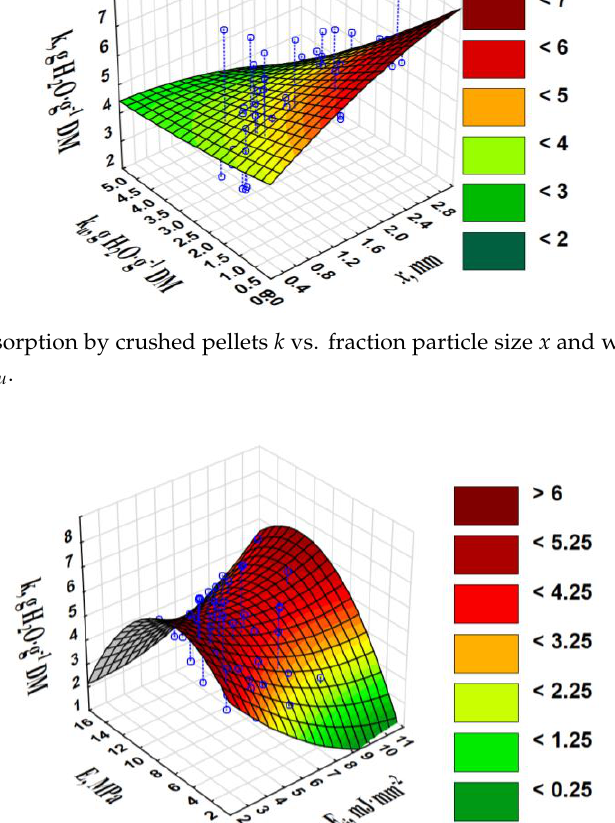
Figure 6. Water absorption by crushed pellets k vs. specific pellet compression work E j and elasticity modulus for pellet compression E .